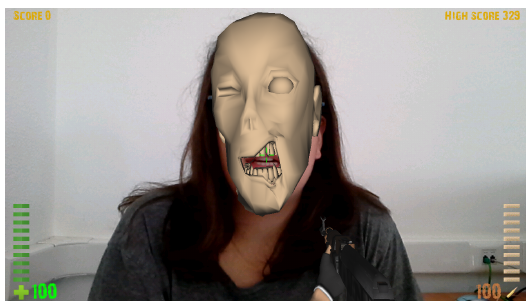
Figure 6: Detection of a zombie.